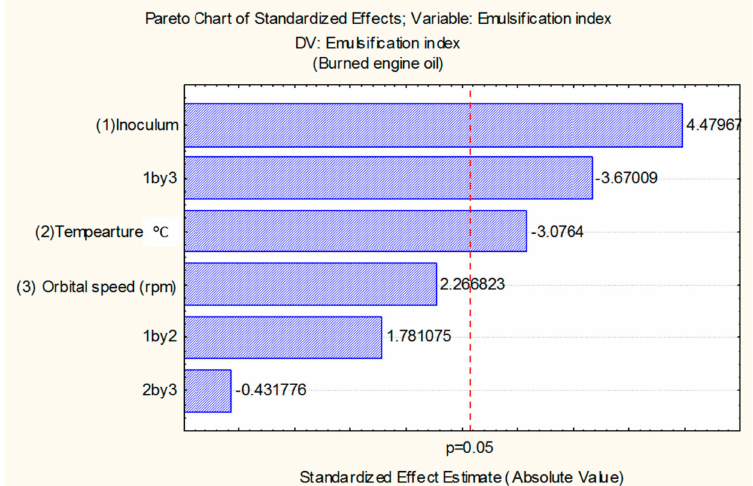
Figure 1. The Pareto chart for determining the influence of inoculum size, temperature, and agitation on bioemulsifier production by Bacillus subtilis .